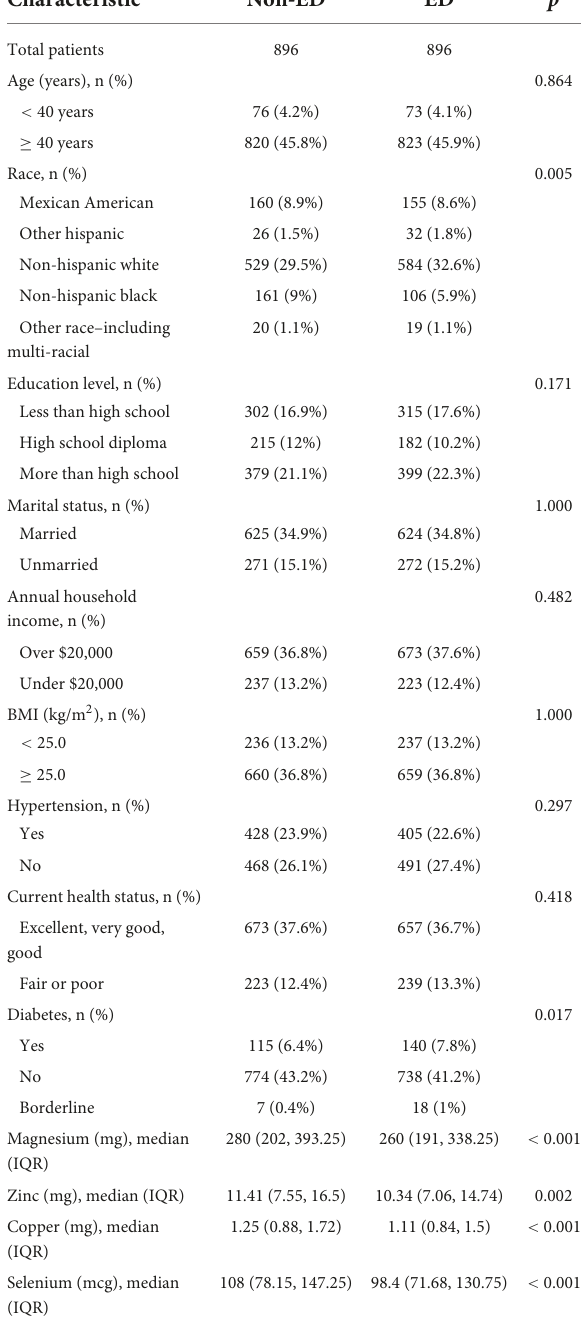
TABLE 4 Baseline characteristics of national health and nutrition examination survey (NHANES) participants between 2001 and 2004 after propensity score matching